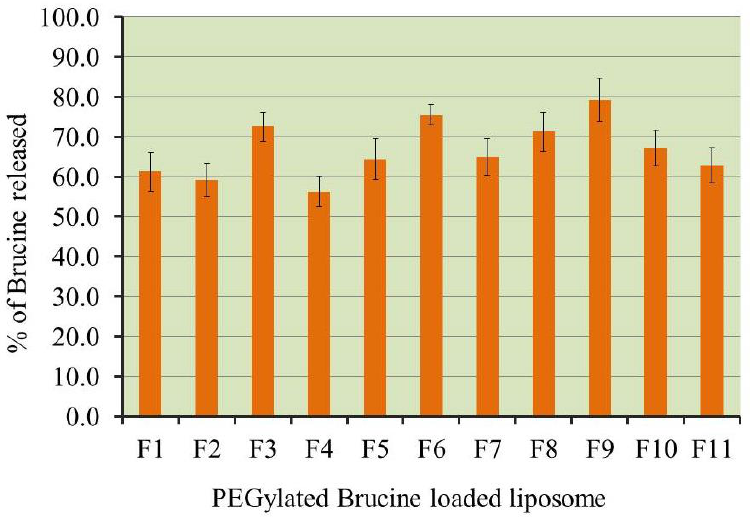
Figure 3. In vitro release of Brucine from different PEGylated liposome formulations in phosphate buffer pH 7.4 at 37 °C. Results are expressed as mean ± SD of three experiments.